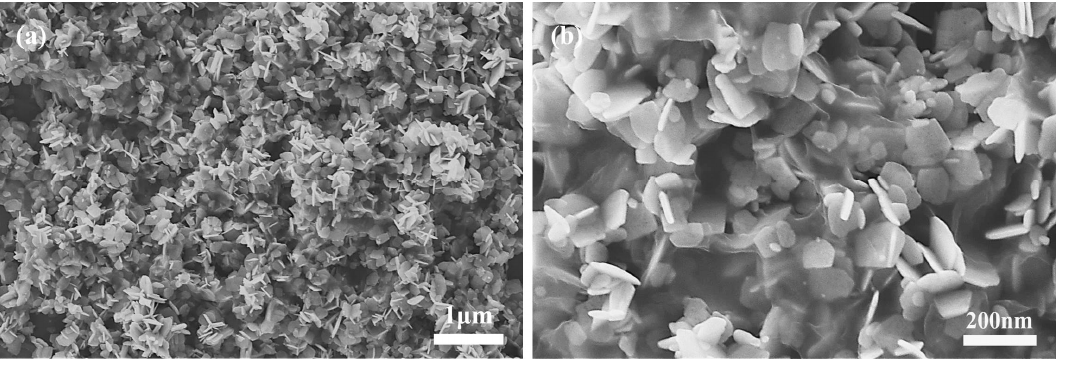
Figure 1. FE-SEM images of the as-synthesized rGO@ZnO 1 − x composites with low ( a ) and high ( b )